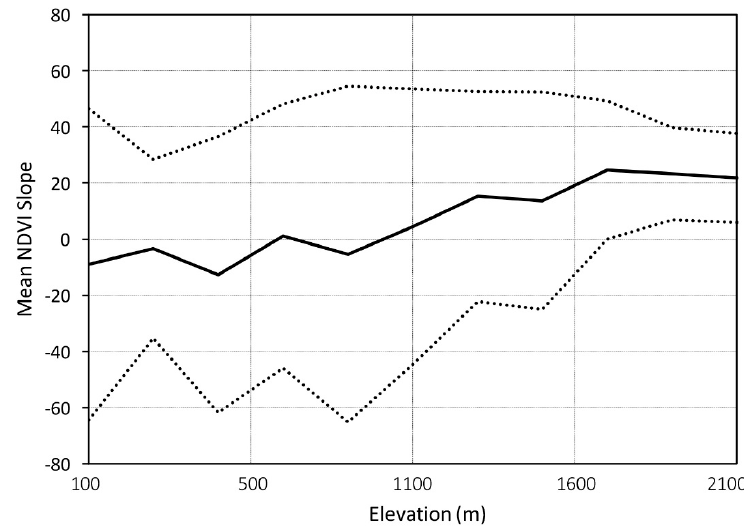
Figure 8. Mean Normalized Difference Vegetation Index (NDVI) slope (plus and minus one standard deviation) versus elevation. Mean NDVI slope values were calculated for each of 11 elevation classes (0–200 m, 201–400 m, etc.), with the exception of a small percentage of pixels in the northern and western portion of the Lam Dong Province where imagery was lacking to conduct the regression analysis, all pixels in the province were used. NDVI slope values are ×10,000 per annum.